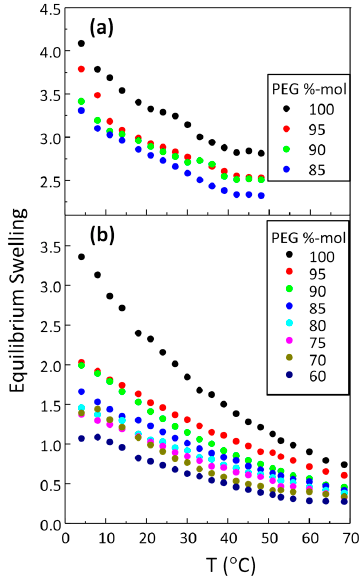
Figure 1. Equilibrium swelling degree of thiol-acrylate (PSA) ( a ) and polyurethane (PU) ( b ) hydrogels as a function of temperature and of composition.